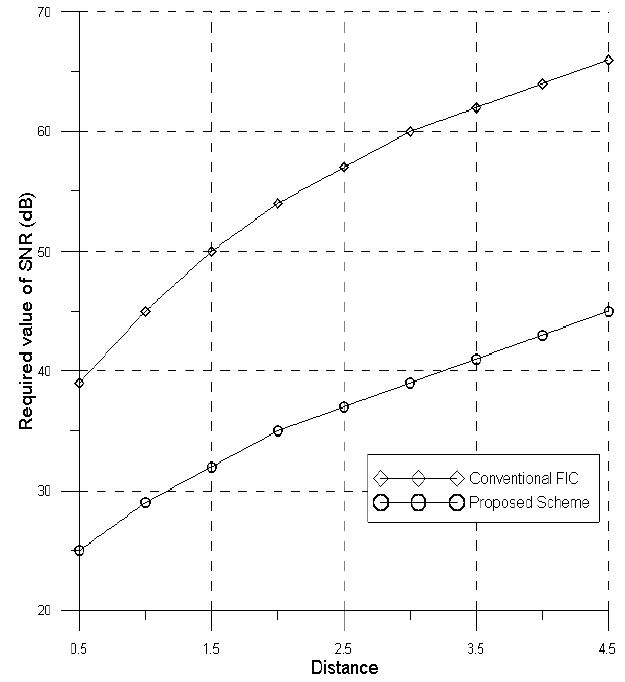
Figure 5. The required value of signal-to-noise ratio (SNR) to obtain targeting BER performance of 10 − 3 .